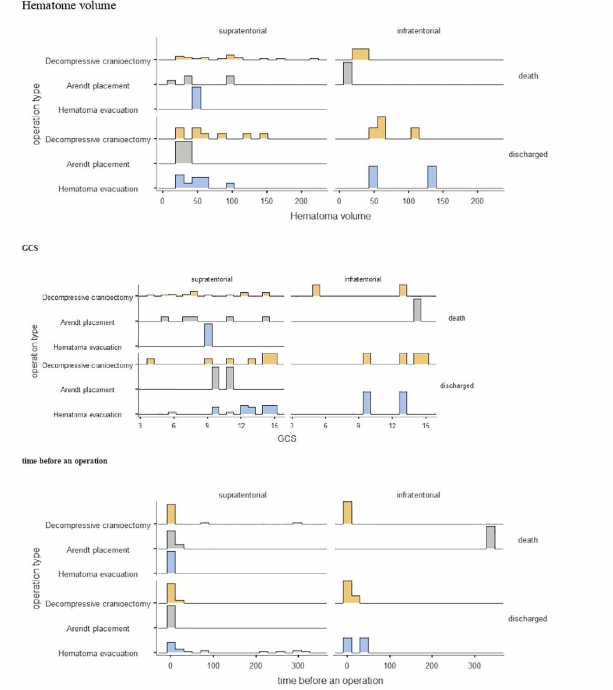
Figure 3 - Correlation between hematoma volume, CGS, time before operation and gender and an